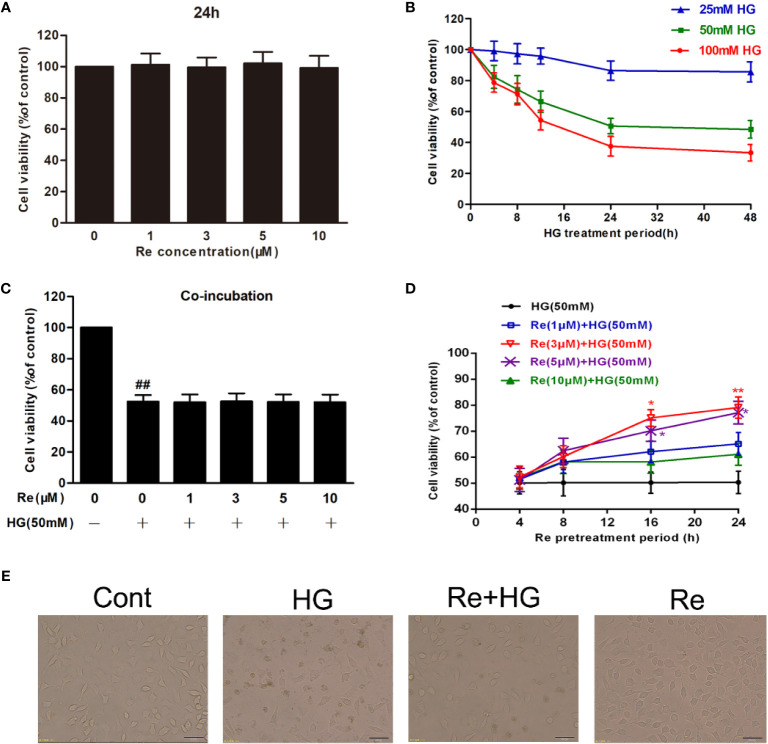
Ginsenoside Re protects RF/6A cells against HG-induced injury. (A) The effect of HG on RF/6A cells at different concentrations for various times. (B) The coincubation with Re and HG for 24 h. (C), The pretreatment with Re for 24 h, and incubation by HG for 24 h. (D) The toxic effect of Re treatment on RF/6A cells. (E) The pretreatment of Re (3 μM) for 24 h and the incubation with HG (50 mM) for another 24 h. Cell activity was tested by MTT. Morphological observation was conducted by an inverted microscope. The data are presented as the mean ± standard error of the mean (n = 5). ##P < 0.01 versus the control group; *P < 0.05, **P < 0.01 versus the HG group. Scale bar, 100 μm. HG, high glucose.